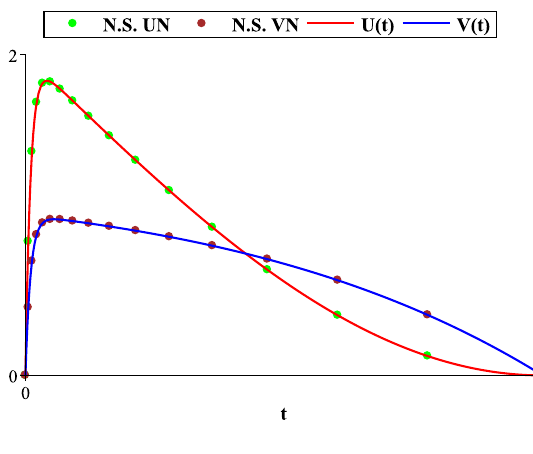
Figure 5. Numerical solution of Example 6.